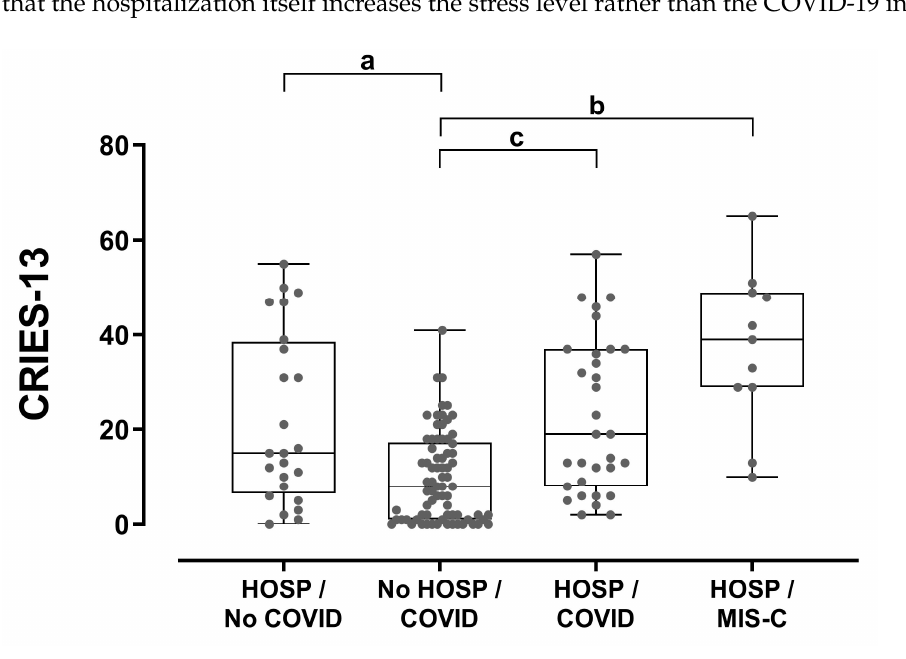
Figure 5. Children’s stress levels (as reported by the parents) in relation to hospitalization and COVID-19 status. Between-group comparisons were performed using Kruskal–Wallis and Dunn’s post hoc tests. a: p = 0.017, b: p < 0.001, c: p = 0.001. HOSP: hospitalization.